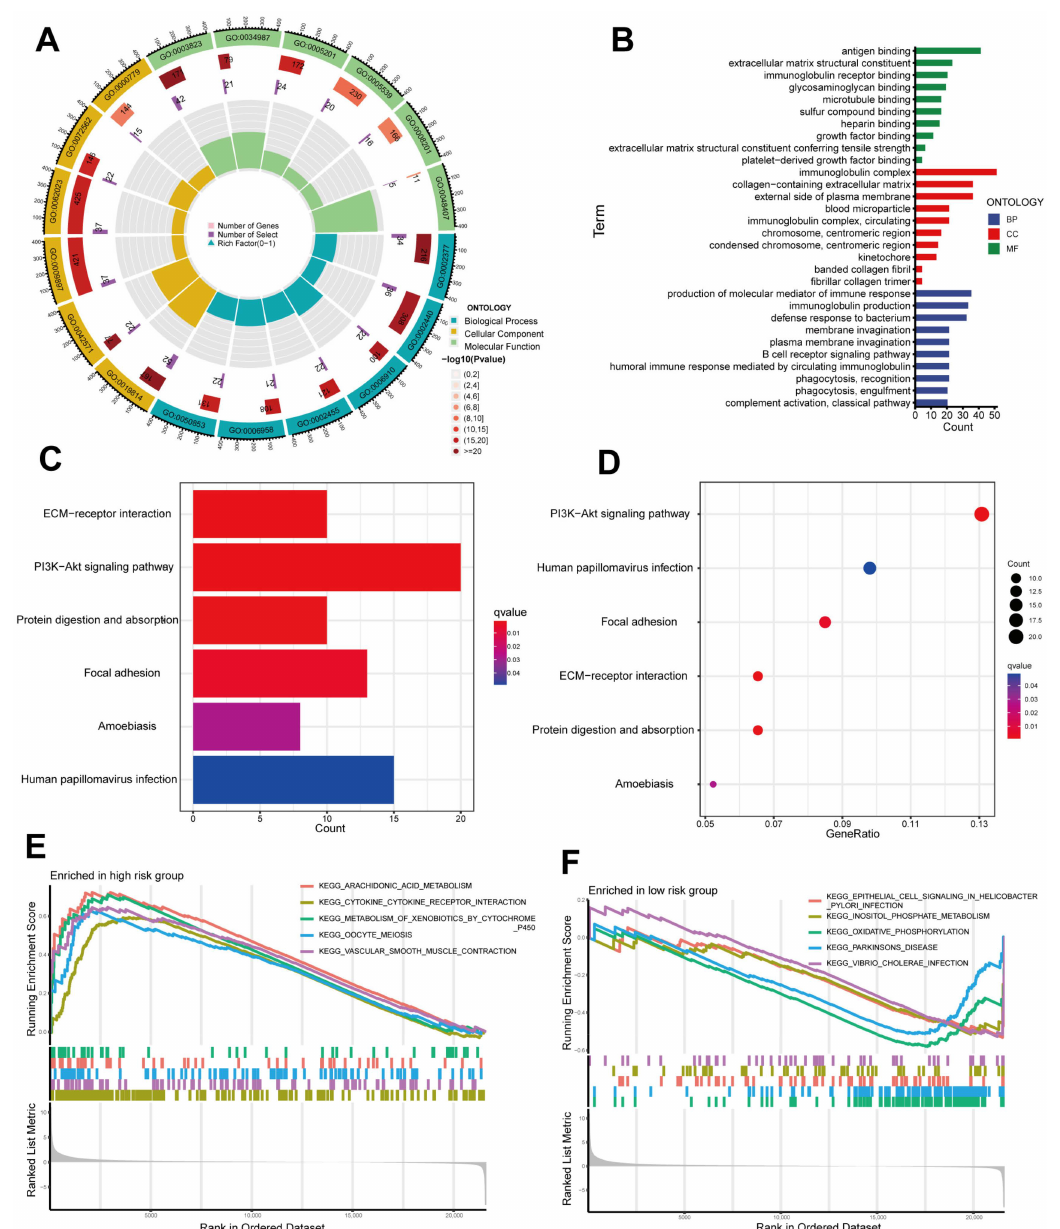
Figure 6. Gene Ontology (GO), Kyoto Encyclopedia of Genes and Genomes (KEGG) and Gene Set Enrichment Analysis (GSEA) between high- and low-risk sets. ( A , B ) GO analysis revealed the diversity of molecular biological processes (BPs), cellular components (CCs) and molecular functions (MFs). ( C , D ) Significantly enriched pathways were identified by KEGG pathway analysis. ( E , F ) GSEA demonstrating the top five enriched pathways in high- and low-risk